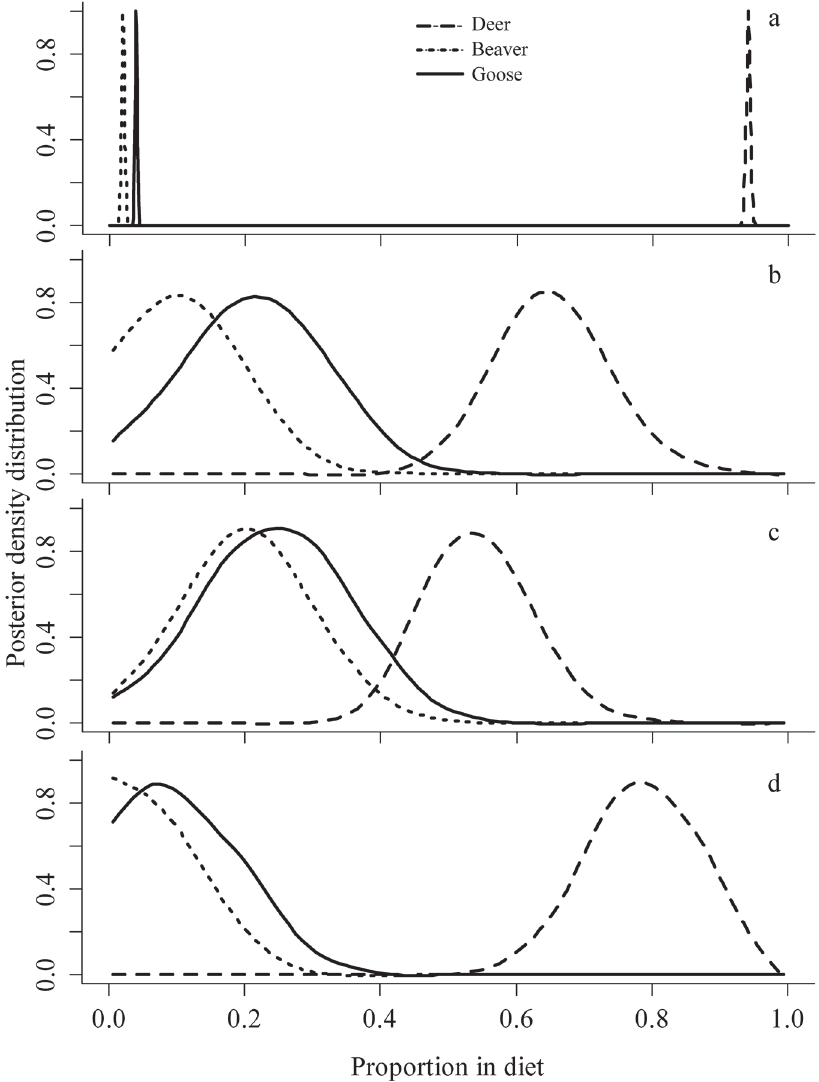
Fig 1. Distribution of proportional contributions of white-tailed deer, beaver, and Canada goose to the diet of gray wolves ( n = 10) during a captive feeding study, Forest Lake, Minnesota, USA, 2011 – 2012. Diet (a) was estimated by bootstrapping the number of each prey (and the range of possible masses from the literature) fed to each wolf. Sections b, c, and d, represent posterior density distributions of Bayesian stable isotope mixing models formulated to estimate proportional contributions based on: non-informative priors (Dirichlet distribution α vector of 1,1, and1, for deer, beaver, and goose, respectively) and wolf discrimination factors estimated from this study (b); non-informative priors (same as b) and fox discrimination factors (c); and minimum informative priors (Dirichlet distribution with α vector of 13, 1, and 1) and wolf discrimination factors from this study